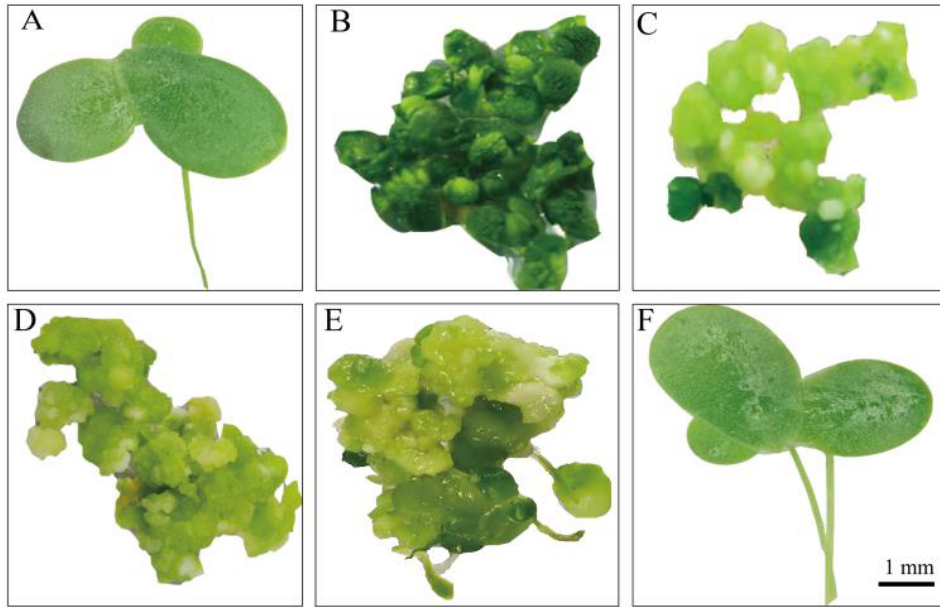
Figure 3. Callus induction and regeneration of L. minor ZH0403. ( A ) Frond; ( B ) callus induced from an explant 3 weeks after inoculation; ( C ) callus induced from an explant 6 weeks after inoculation; ( D ) 8-week-old callus; ( E ) 2 weeks of regeneration following ( D ); ( F ) 4 weeks of regeneration following ( D ).